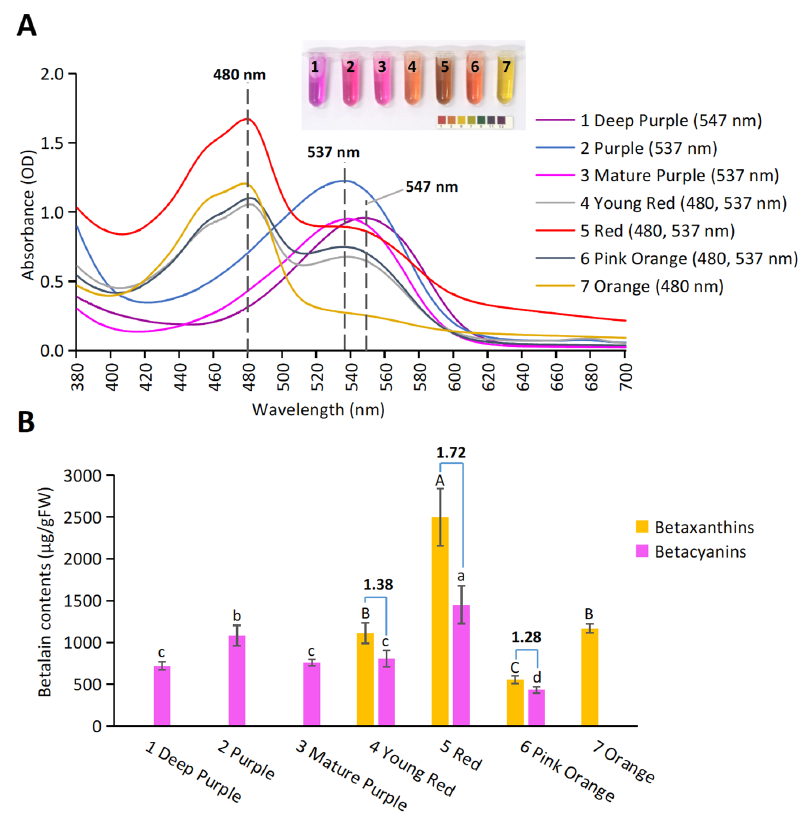
Figure 3. Absorption spectra scanning ( A ) and the betalain composition analysis ( B ) for the BBEs from Bougainvillea bracts. For ( A ), the tubes show the color of the scanned BBEs and the wavelength value in the bracket indicates the λ max. The universal pH indicator paper was shown as a color reference. For ( B ), ratios of Bx/Bc were shown for bracts with both Bx and Bc. The values were based on three independent replicates. Significant differences were calculated by one ‐ way ANOVA and Duncan’s test at p < 0.05. The uppercase and lowercase letters show the significant differences among samples for Bx and Bc, respectively.